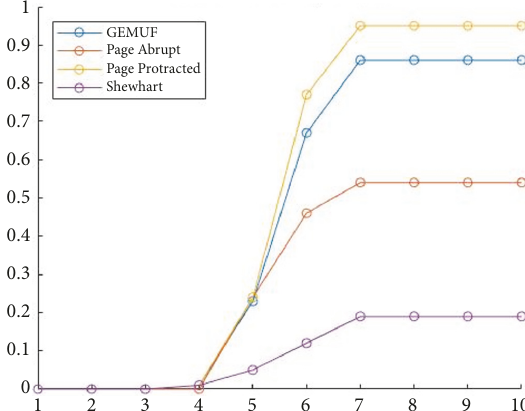
Figure 4: Comparison of statistical tests for a protracted material loss. The y-axis represents the detection probability, and the x-axis is the material balance